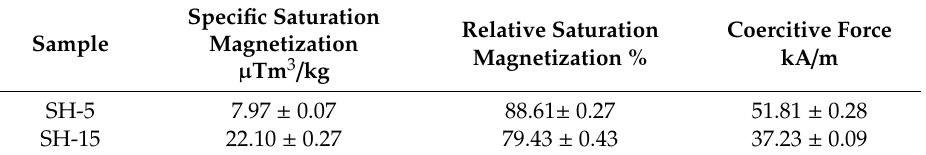
Table 6. Magnetic and coercivity characteristics.